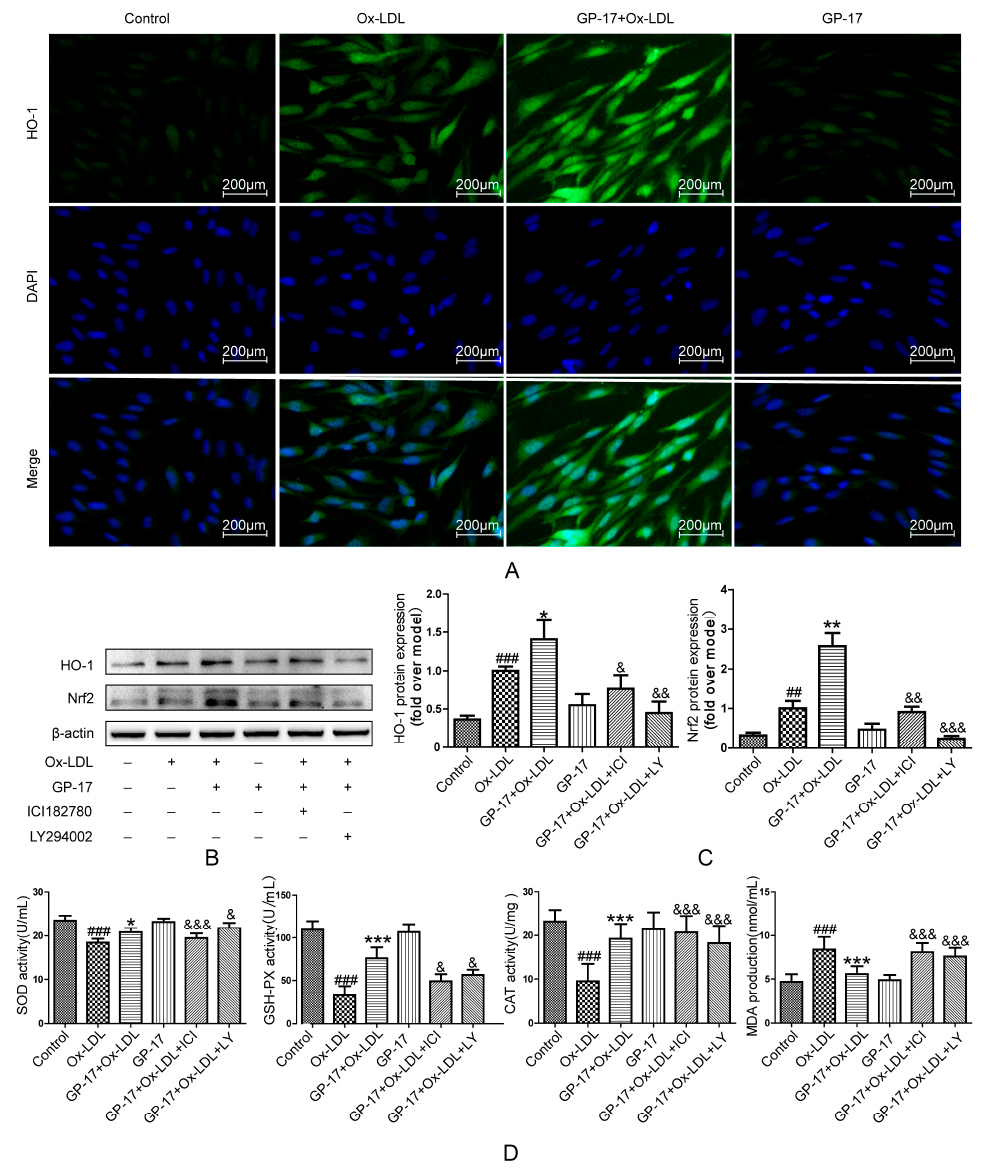
Figure 10. GP-17 protected HUVECs against Ox-LDL-induced oxidative stress by increasing the antioxidant enzymes and antioxidant proteins. ( A ) The expression of HO-1 was analyzed by immunofluorescence assays; ( B , C ) The expressions of antioxidant proteins mediated by GP-17 in Ox-LDL-induced HUVECs were abolished by pretreatment with ICI182780 or LY294002; ( D ) the levels of SOD, GSH-Px and CAT activities and MDA production mediated by GP-17 in Ox-LDL-induced HUVEC injury were determined and abolished by pretreatment with ICI182780 or LY294002. The values are expressed as the mean ± S.E.M. from three independent experiments. ## p < 0.01; ### p < 0.001 vs. Control; * p < 0.05; ** p < 0.01; *** p < 0.001 vs. Ox-LDL; & p < 0.05; && p < 0.01; &&& p < 0.001 vs. GP-17 + Ox-LDL. HO-1, heme oxygenase 1; SOD, superoxide dismutase; GSH-Px, glutathione peroxidase; CAT, catalase; MDA, malondialdehyde.